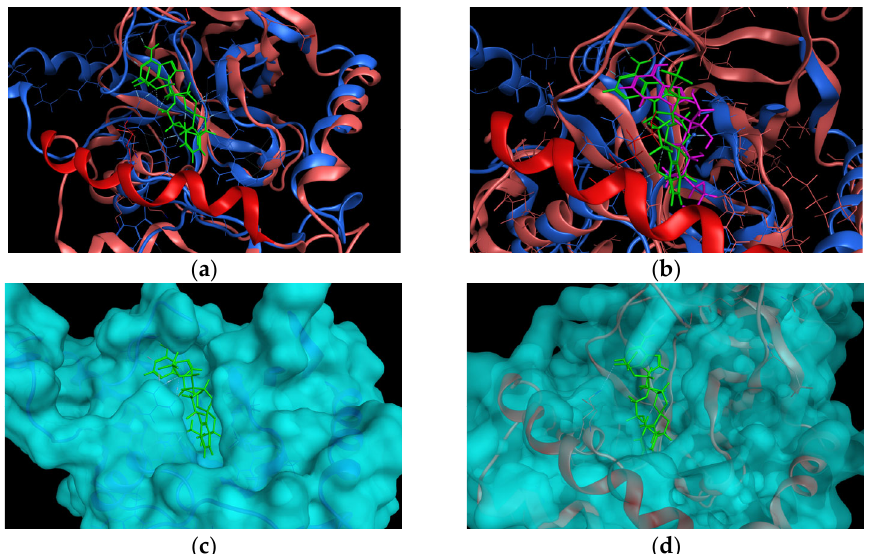
Figure 3. ( a ) Superimposition of 5AGR mtbLeuRS (blue color) with co ‐ crystallized adduct ( S ) ‐ 3 ‐ (aminomethyl) ‐ 7 ‐ ethoxybenzo[ c ][1,2]oxaborol ‐ 1(3 H ) ‐ ol ‐ AMP as a ligand (light green color) and 2WFD hLeuRS (pink color) with highlighted additional alfa ‐ helix (red color). ( b ) Superimposition of 5AGR mtbLeuRS (blue color) with ligand (green color) and 6LPF hLeuRS (pink color) with co ‐ crystallized 2’ (L ‐ norvalyl)amino ‐ 2’ ‐ deoxyadenosine and 5’ ‐ O ‐ (L ‐ leucylsulfamoyl)adenosine as a ligand (purple color) and highlighted additional alfa ‐ helix (red color). ( c ) 5AGR mtbLeuRS with a calculated surface area of the enzyme (light blue color) and co ‐ crystallized adduct (light green color). ( d ) 2WFD hLeuRS with a calculated surface area of the enzyme (light blue color) and co ‐ crystallized adduct from 5AGR (light green color).